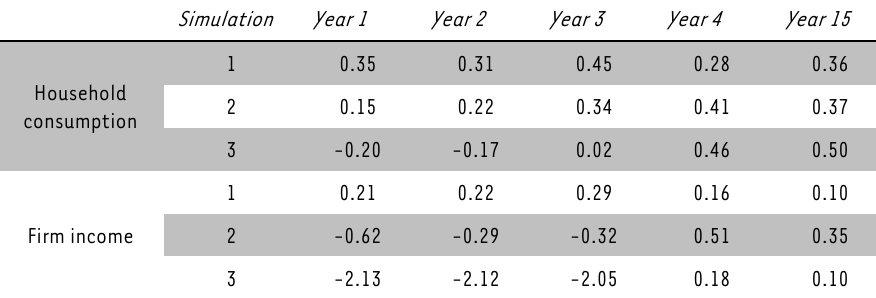
TABLE 4: Household consumption and firm income (% change from